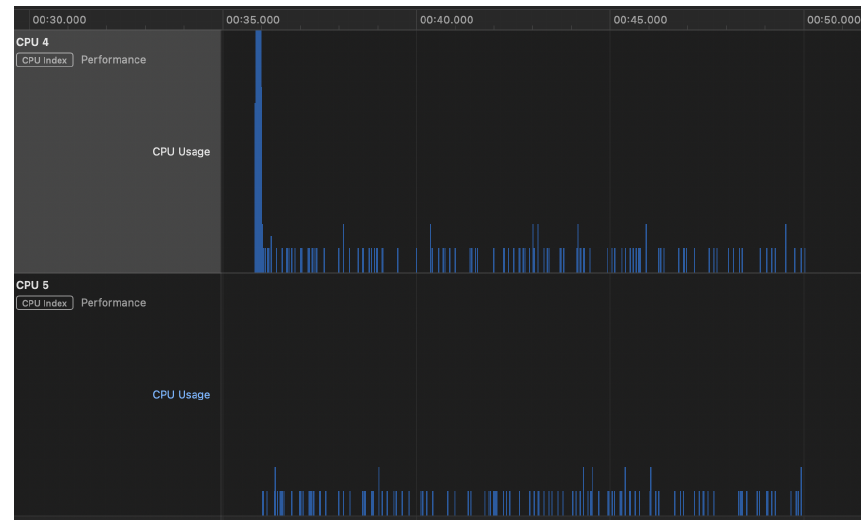
Figure 14. Percentage of CPU usage on the iPhone during a transfer of 100 OTPs.